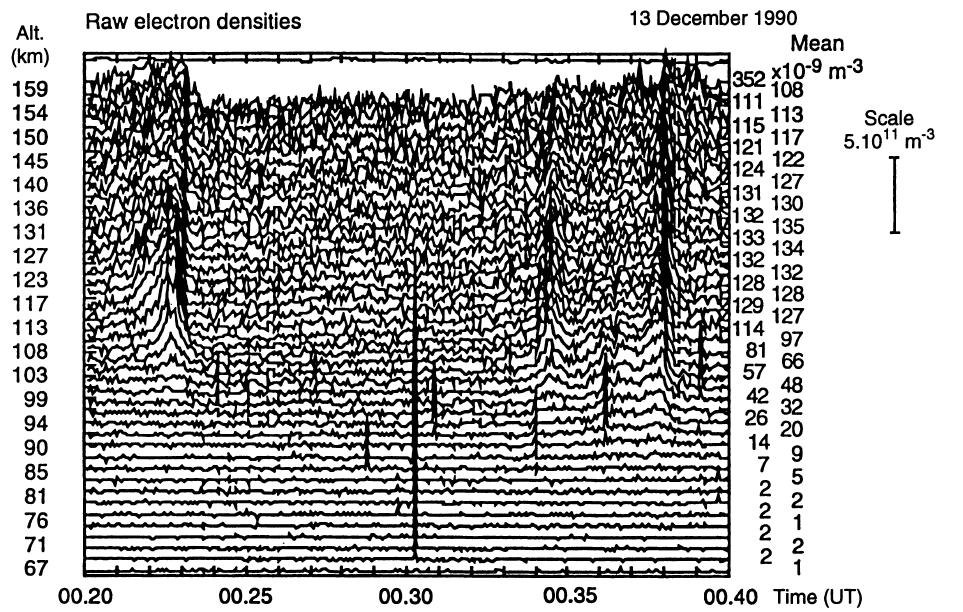
Table 1. Optical meteors observed at